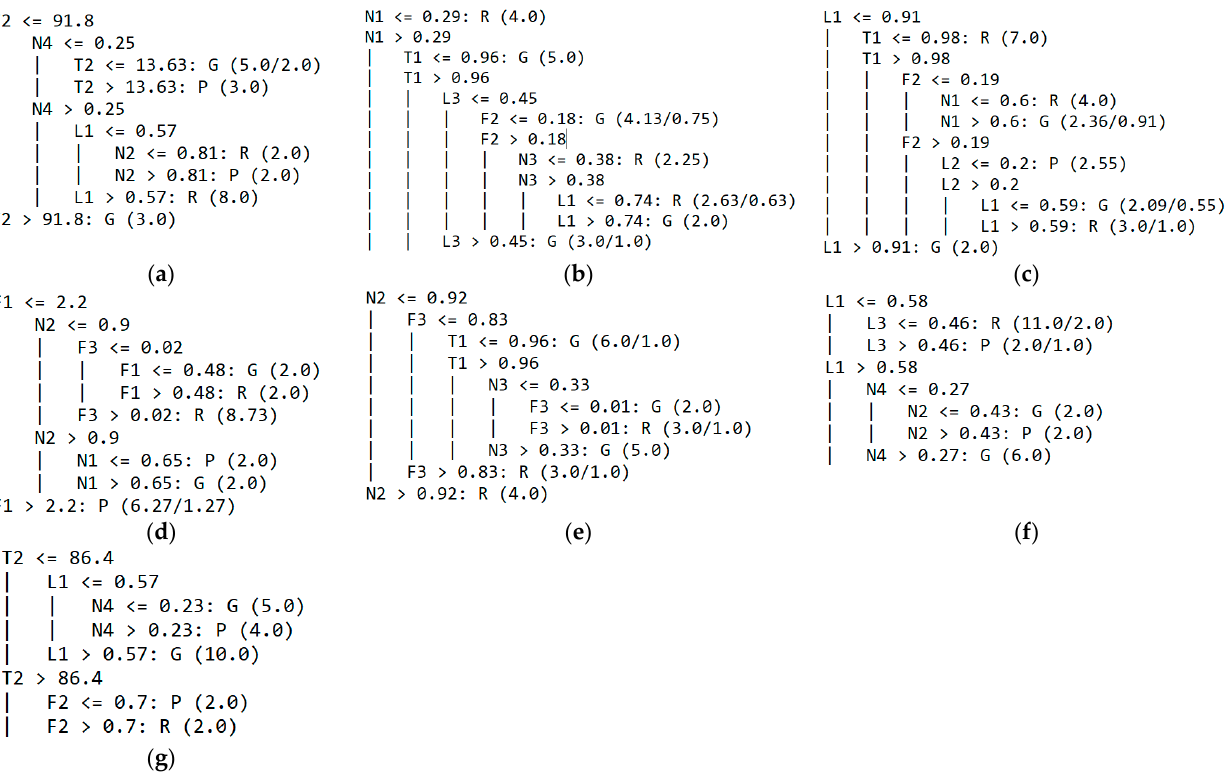
Table 11. Confusion matrix of the proposed meta-learning for the Naïve Bayes classifier.